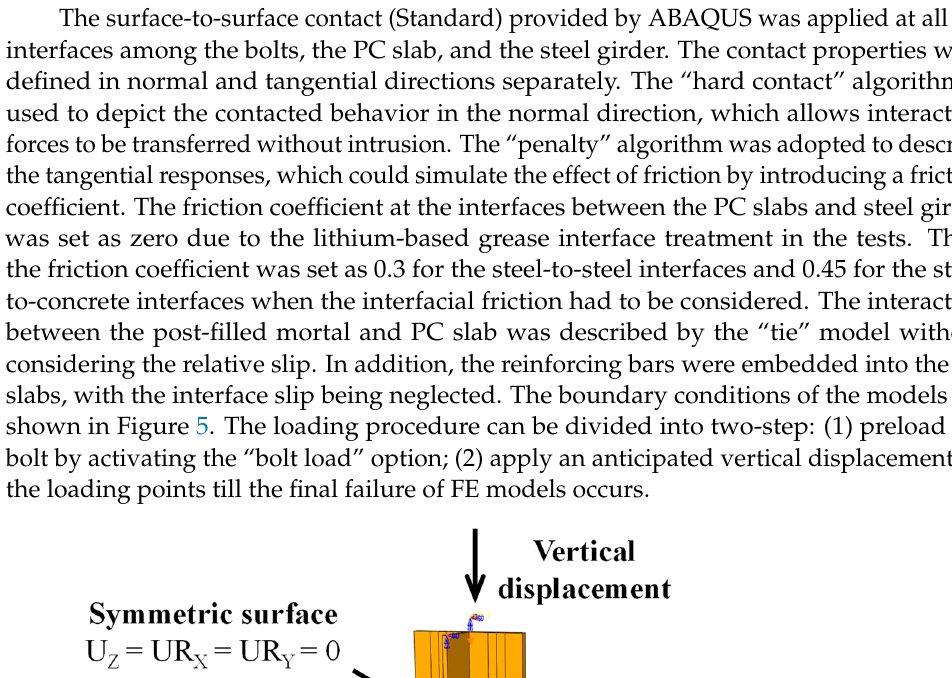
Figure 4. Mesh details of the FE models.